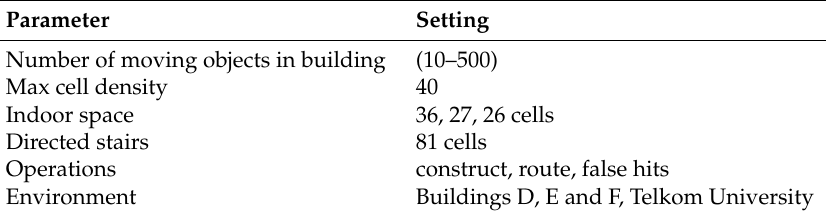
Table 2. Parameters and their